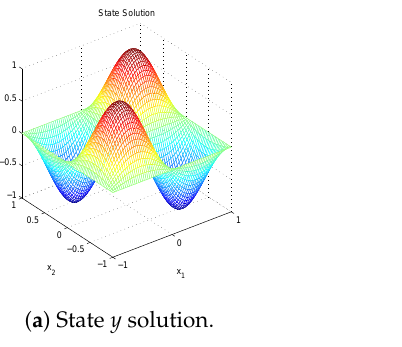
Figure 1. Numerical Solution of the state y and control u at h = 2 − 6 and δ = 10 − 5